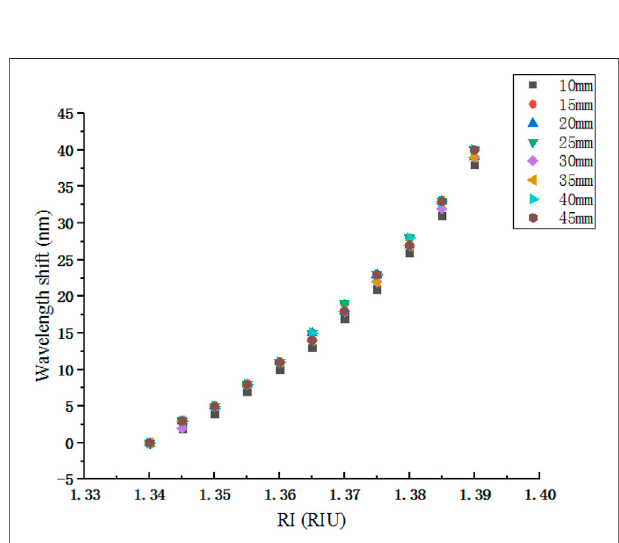
FIGURE 5 | Wavelength shift of L variation when D 1 (cid:2) 30 μ